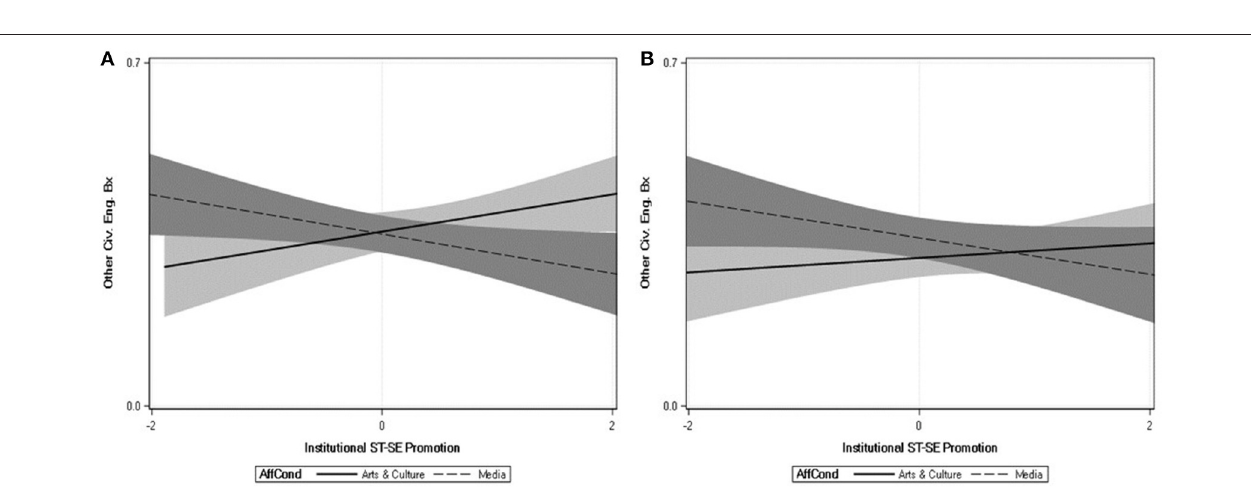
FIGURE 2 | Relations between other (non-voting) civic engagement behaviors (y axis) and the extent to which the institutions of Arts and Culture and Media are perceived to promote relatively more self-transcendence vs. self-enhancement values (x axis) in the UK (A) and the US (B) . Shaded regions reflect the 95% confidence regions around the regression